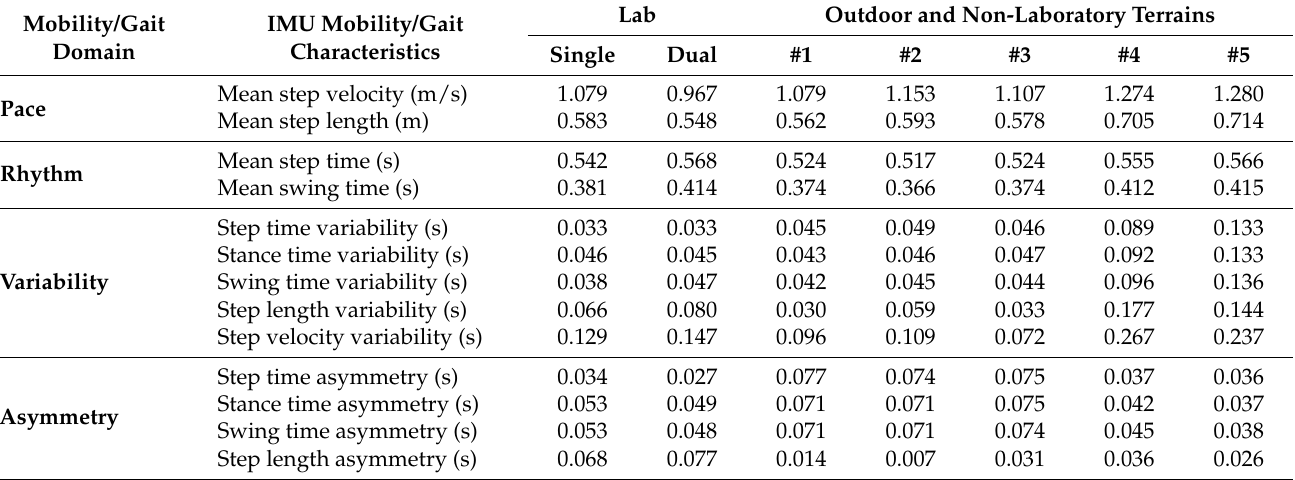
Table 2. Mobility/gait characteristics and terrain types over 30 s walk, with